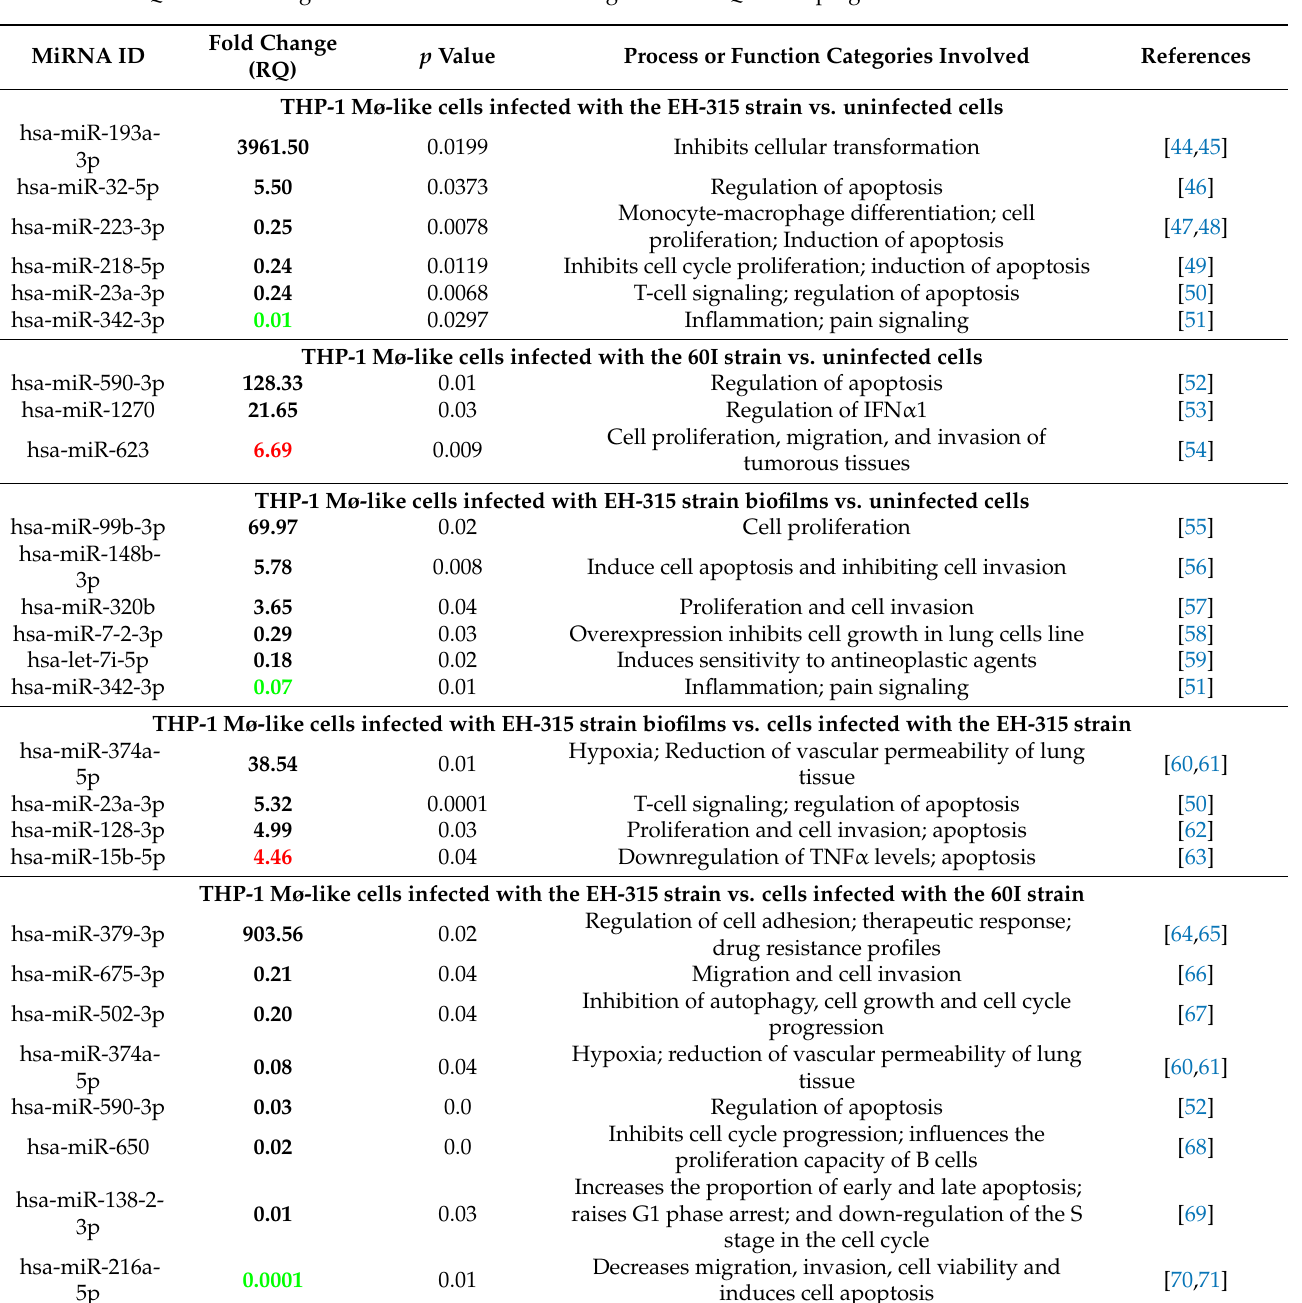
Table 1. Differentially expressed miRNAs in infected and uninfected THP-1 Mø-like cells. Relative quantification (RQ) values of miRNAs were determined with the DataAssist v3.01 software from triplicate measurements using the ∆∆ Cq method. RQ from downregulated miRNAs are shown in green and RQ from upregulated miRNAs are shown in red. Fold Change MiRNA ID